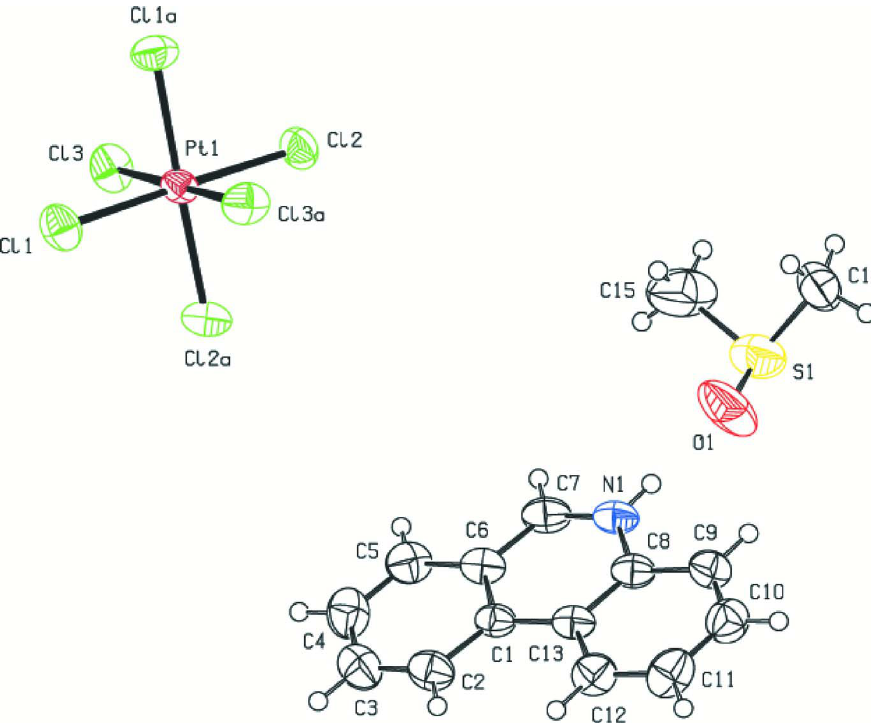
Figure 1 ORTEP - 3 view of the title molecule, with the atom-numbering scheme and 50% probability displacement